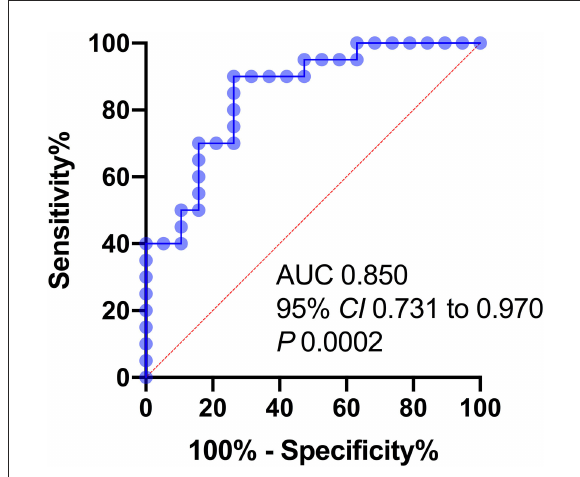
FIGURE2 Receiver operator characteristic (ROC) curves of variables predicting END 24h after stroke onset. AUC, area under the curve; NIHSS, NIH stroke scale; pNFL, plasma neurofilament light chain